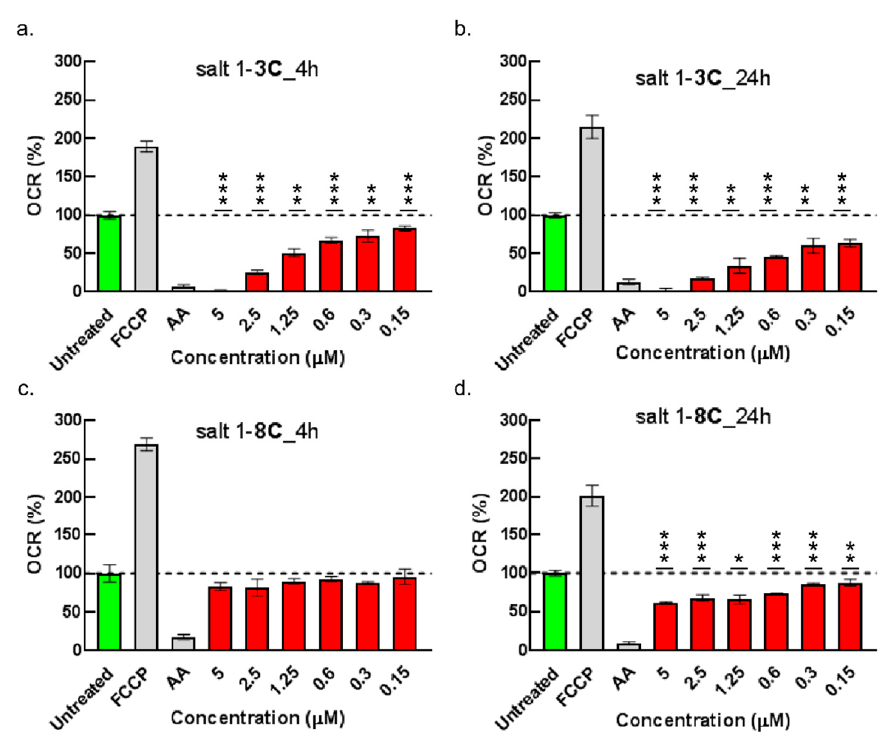
Figure 6. Salts influence oxygen consumption. A-375 cells were treated with the indicated concentrations of salt 1- 3C ( a , b ) and salt 1- 8C ( c , d ) for 4 h ( a , c ) and 24 h ( b , d ). Oxidative respiration was measured using MitoXpressXtra Oxygen Consumption Assay. Control cells are indicated in green. Carbonyl cyanide-p-triflouromethoxyphenyl-hydrazone (FCCP) (2 µM) and antimycin (AA) (500 µM) were used as positive and negative controls, indicated in grey. Test compounds are indicated in red. The results represent the mean ± SD of technical triplicates; * p < 0.05, ** p < 0.01, *** p < 0.001.